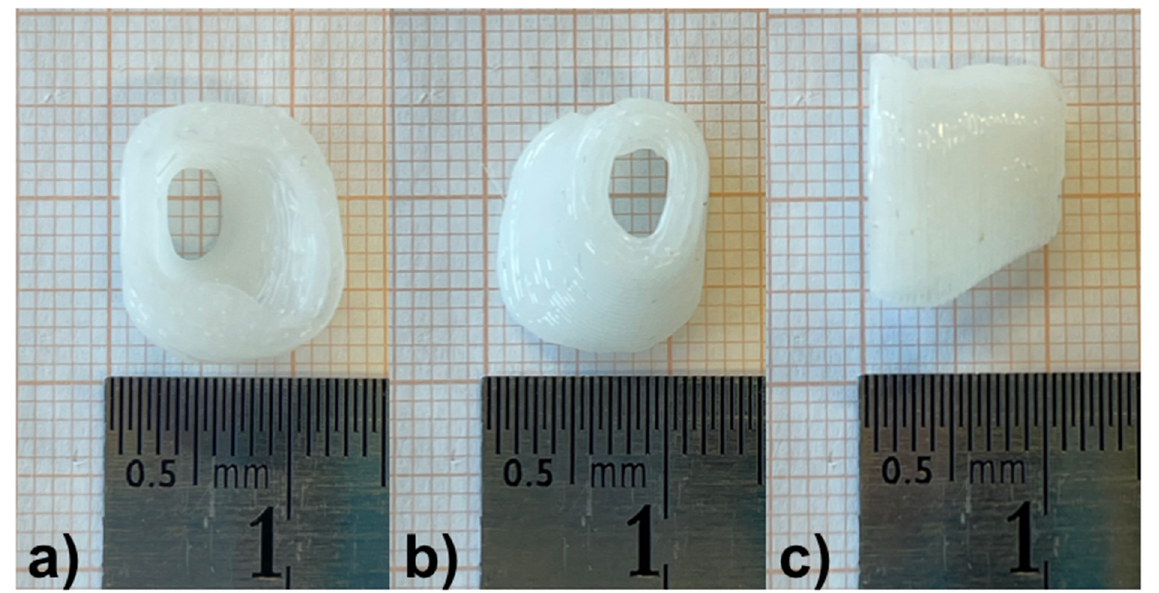
Figure 7. The patient-individualized DEX- (1%) and cipro- (0.3%) containing hollow EECI with a wall thickness of 1.5 mm after the printing process. ( a ) Top view of the side of the implant facing the opening of the EEC; ( b ) top view of the side of the implant facing the tympanic membrane; ( c ) side view of the implant showing its height.